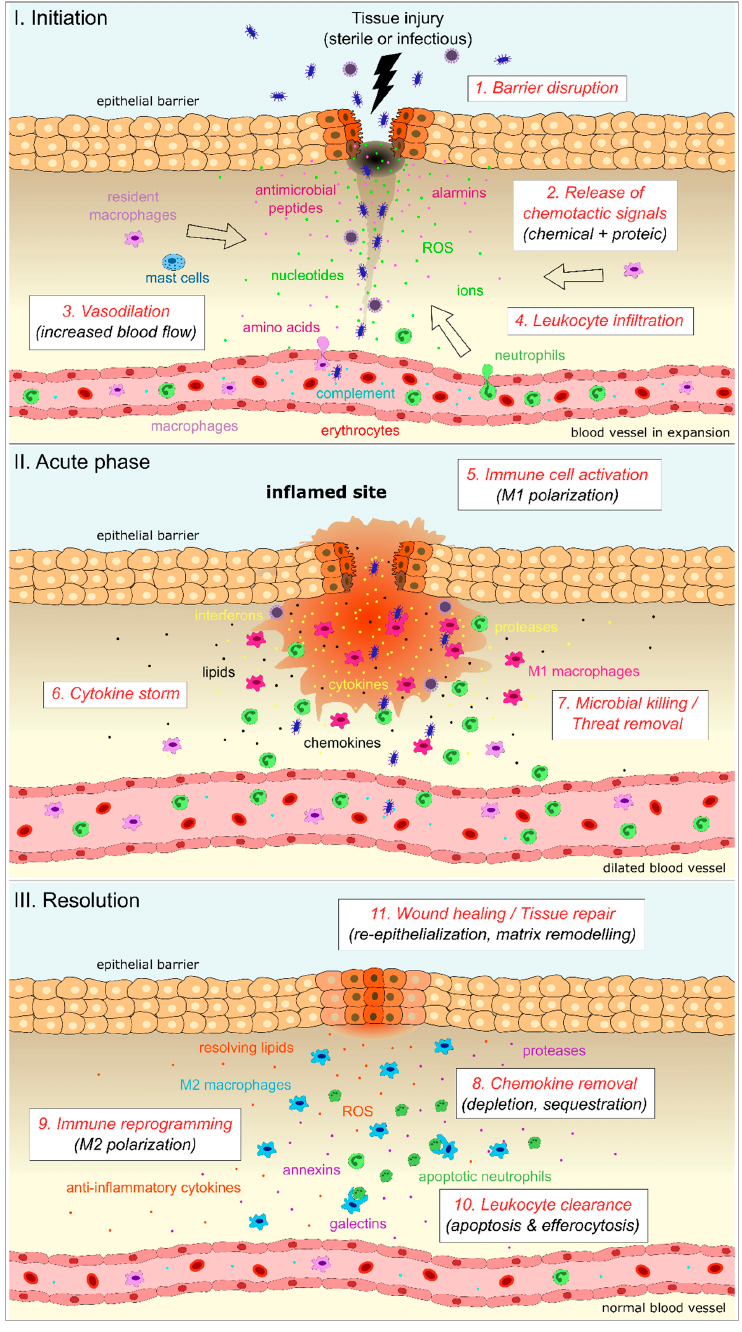
Figure 1. Cellular and molecular actors of inflammation during the three phases of the inflammatory response. I-Initiation: upon sterile or infectious tissue injury, disruption of the epithelial barrier leads to the release of early inflammatory signals that can be either chemicals or proteins. These signals modulate the blood flow by increasing vasodilation and generate chemotactic gradients allowing for immune cell infiltration within the injured tissue. Unfilled arrows indicate the direction of mi- gration for resident and infiltrated immune cells. II-Acute phase: once recruited at the site of injury, immune cells get activated into a pro-inflammatory phenotype, leading to massive production of pro- inflammatory mediators (“Cytokine storm”) and threat removal. III-Resolution: tissue repair is then initiated by chemokine depletion (through proteolytic degradation or receptor-dependent sequestra- tion) and immune cell reprogramming toward an anti-inflammatory/pro-resolving phenotype. This switch ends the storm, leads to leukocyte clearance and healing, and ultimately restores